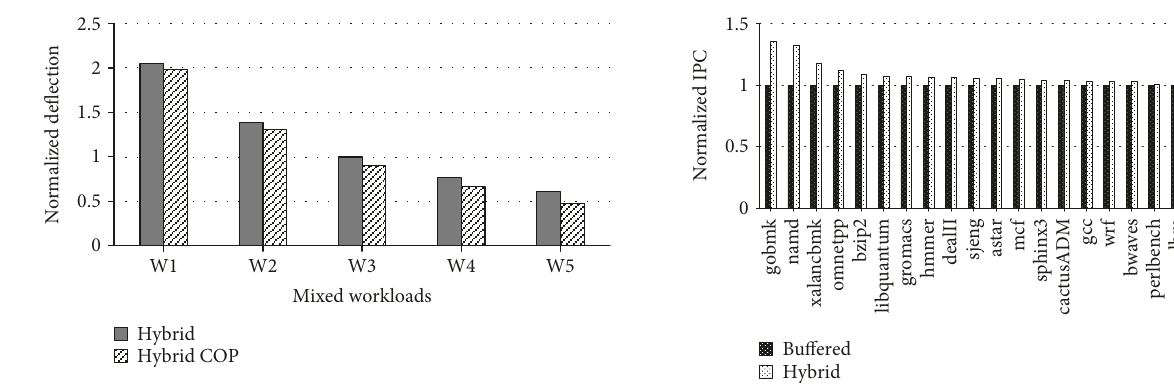
Figure 15: Normalized de fl ection rate of hybrid loads with 128 threads.